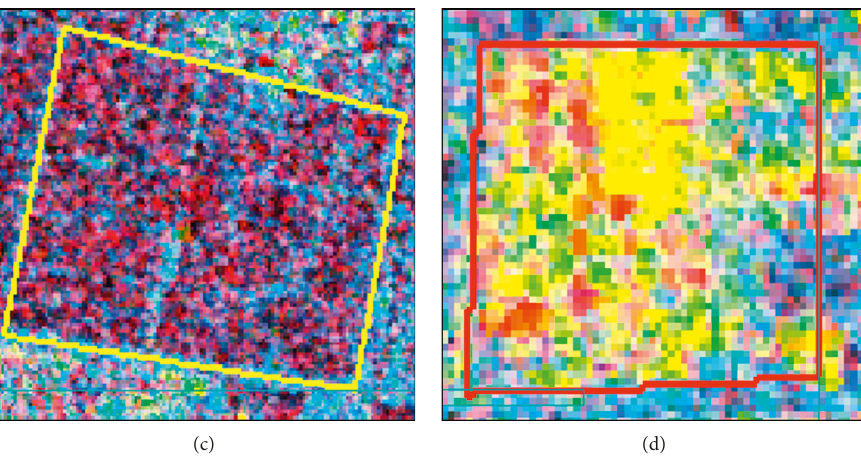
Figure 7: Typical examples of the four types of area examined using H / A /Alpha composite color images based on June 2014 Radarsat-2 data ( H : red layer; A : green layer; Alpha: blue layer). (a) Bare soil, (b) vegetation, (c) mixing, and (d) urban/city.